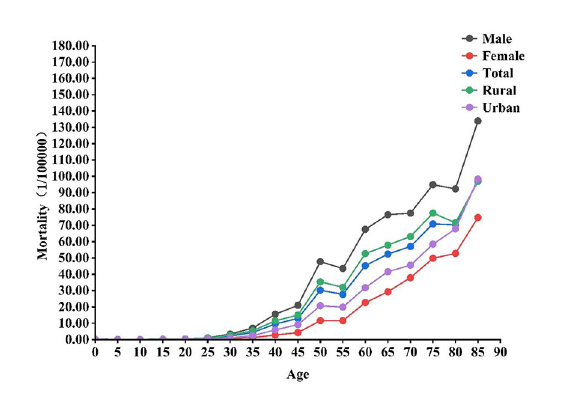
FIGURE2 Age-specific mortality rates of liver cancer by sex and region in Yunnan, 2015–2019.